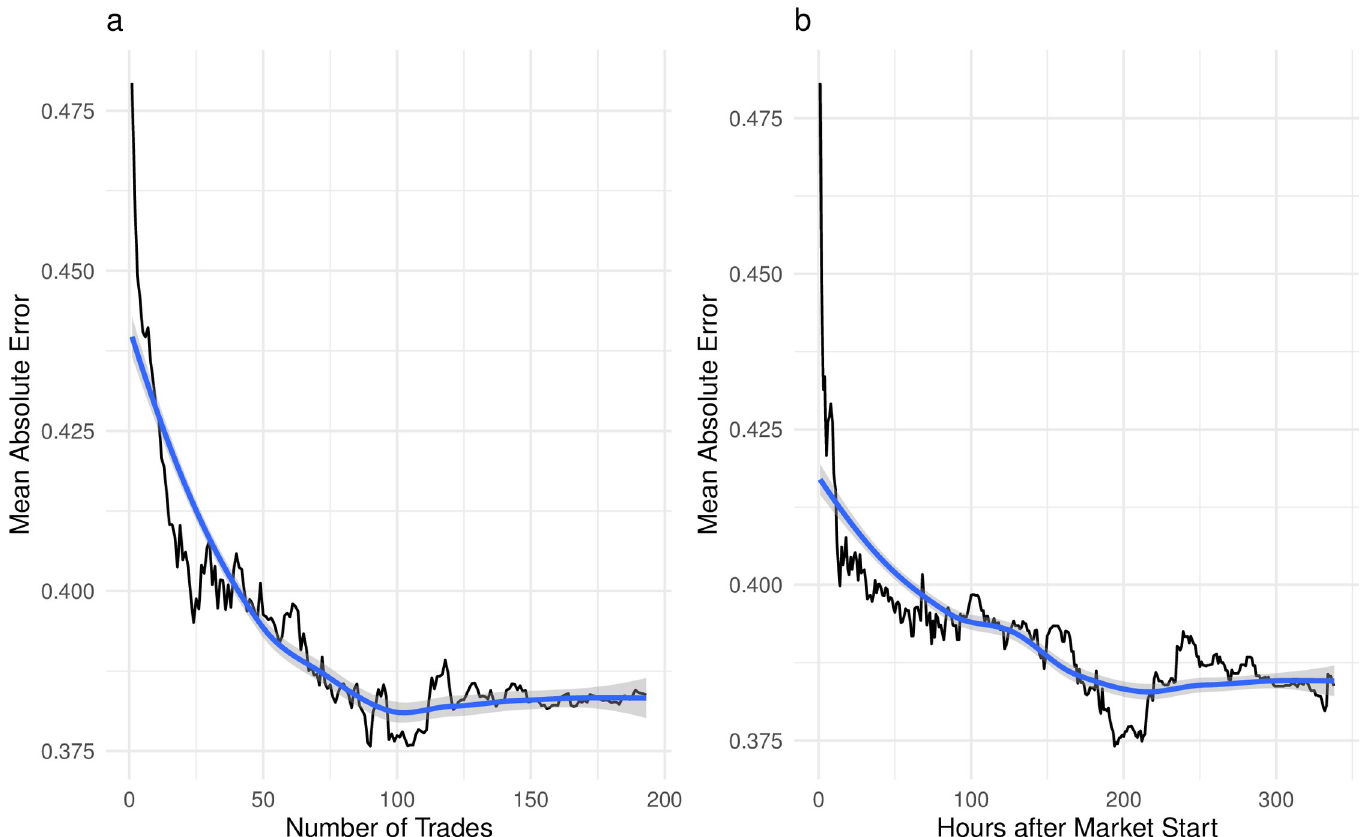
Fig 4. Market dynamics. Each of the subplots represent reduction in absolute error as the market progresses. Both plots include the mean (across 103 findings) absolute error in black, and the LOESS smoothing in blue. Plot (a) describes error reduction over number of trades and plot (b) describes error reduction over time. We find that the error falls quickly at first, however error does not reduce